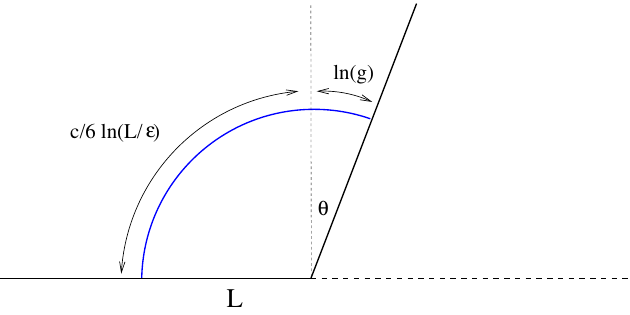
Figure 6 . Calculation of entanglement entropy for an interval of length L including the boundary in the vacuum state of a holographic BCFT. The geometry is locally Poincar(cid:19)e-AdS, with the ETW brane at a constant angle (cid:18) = arcsin( T ). The boundary entropy is the x > 0 portion of the RT